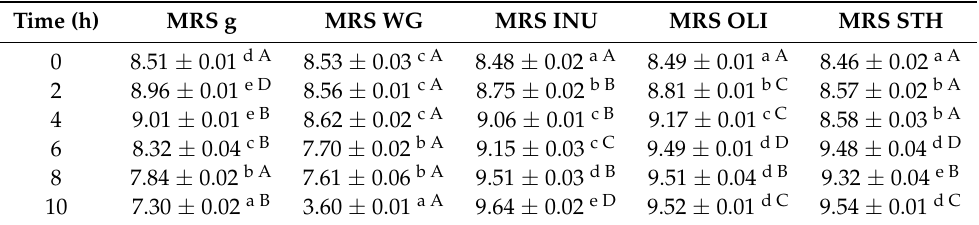
Table 1. Viable count (log10 cfu/mL) of probiotics for 10 h of monitoring at 37 ◦ C on MRS medium culture. Time (h) MRS g MRS WG MRS INU MRS OLI MRS